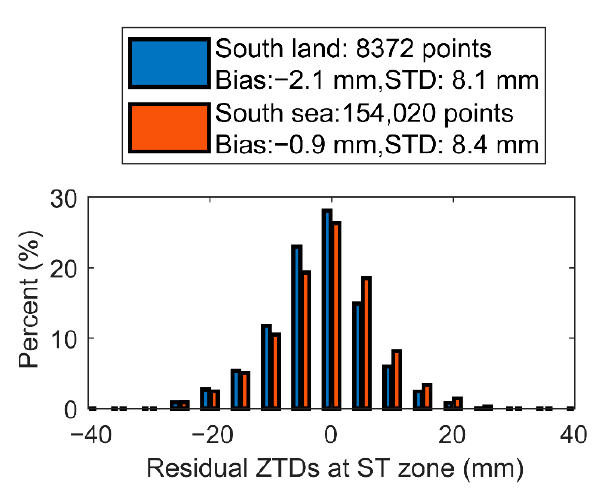
Figure 7. Statistics and distribution of residual ZTDs of atmPrf and echPrf in 2008 in ( a ) the south temperate (ST) zone; and ( b ) the north temperate (NT) zone. Blue indicates land and red indicates sea.